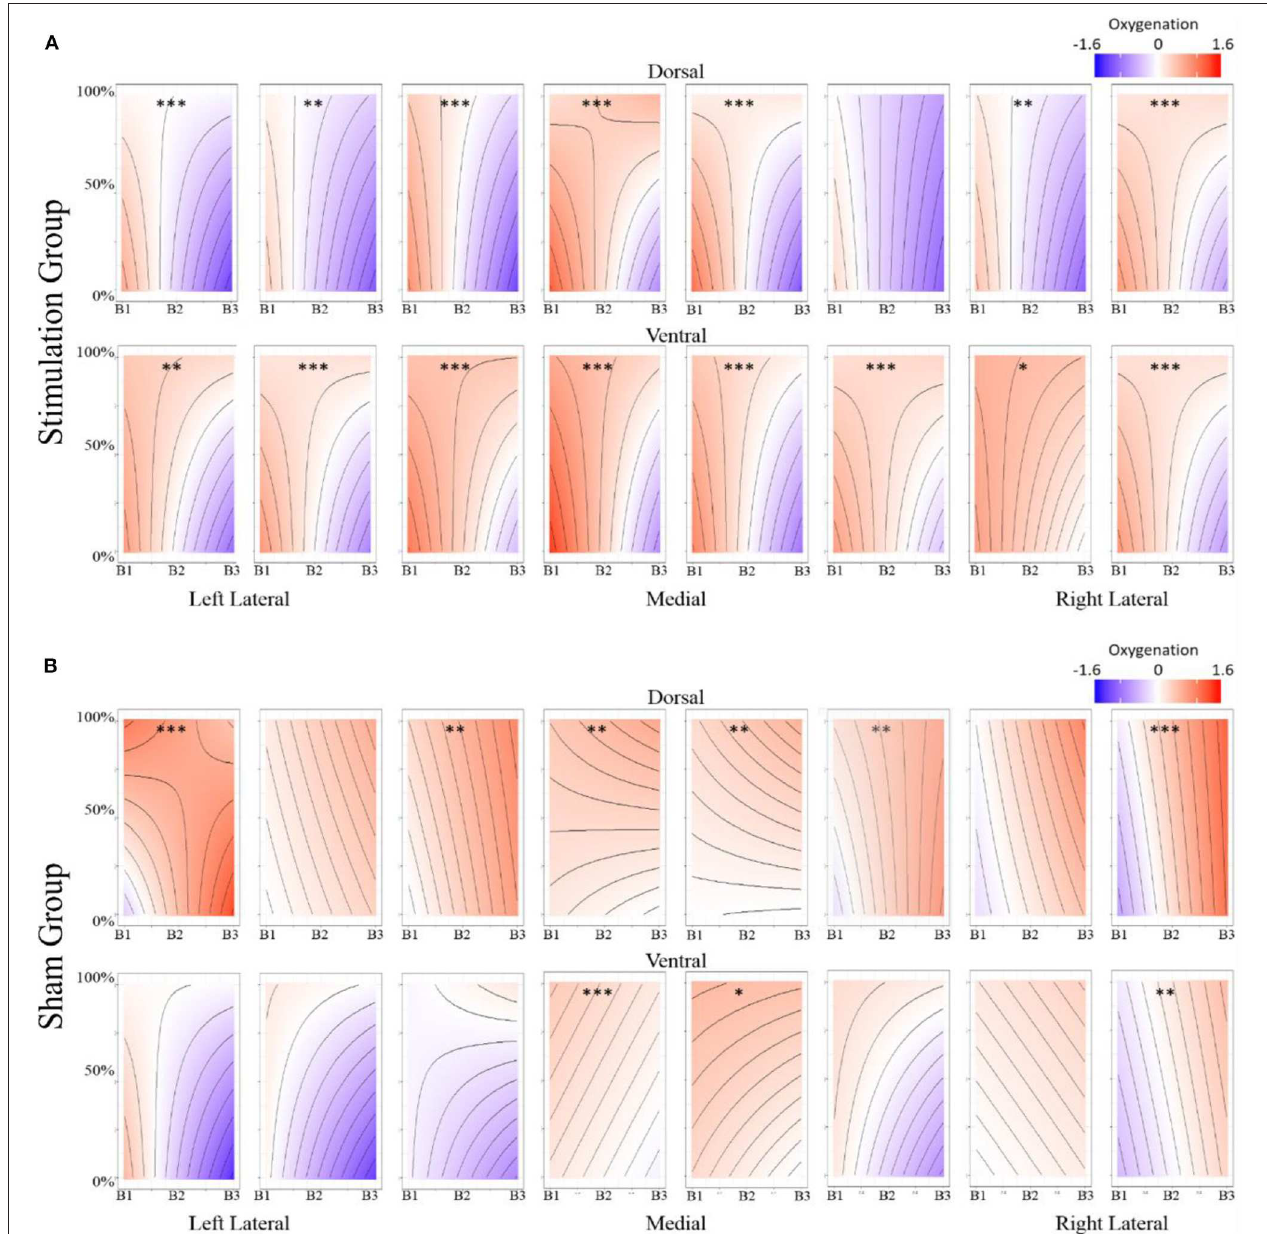
FIGURE 8 | (A) Stimulation condition three-way interaction between relationship of spatial memory accuracy and oxygenation as a function of experimental block. Dorsal optodes are odd numbered, ventral optodes are even numbered. Optodes are ordered from least on the left to greatest on the right. * p < 0.05, ** p < 0.01, *** p < 0.001. (B) Sham condition three-way interaction between relationship of spatial memory accuracy and oxygenation as a function of experimental block. Contrast between sham and stimulation conditions, * p < 0.05, ** p < 0.01, *** p <